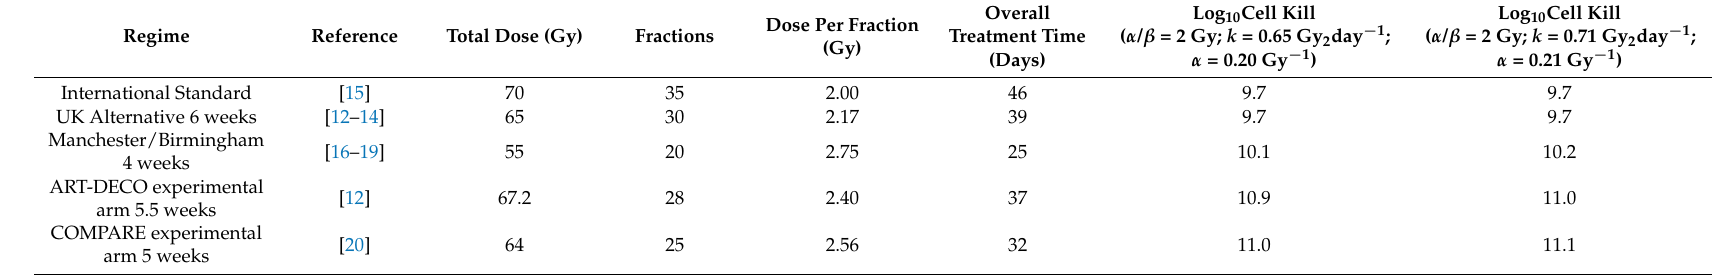
Table 1. Comparison of log cell kill values predicted for various regimes administered with synchronous chemotherapy using parameters derived in this